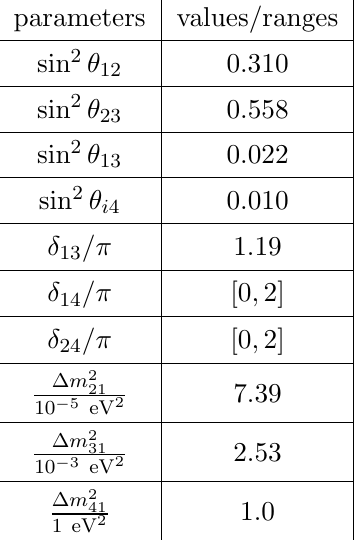
Table 3 . List of neutrino oscillation parameter values (or ranges) used in our phenomenological